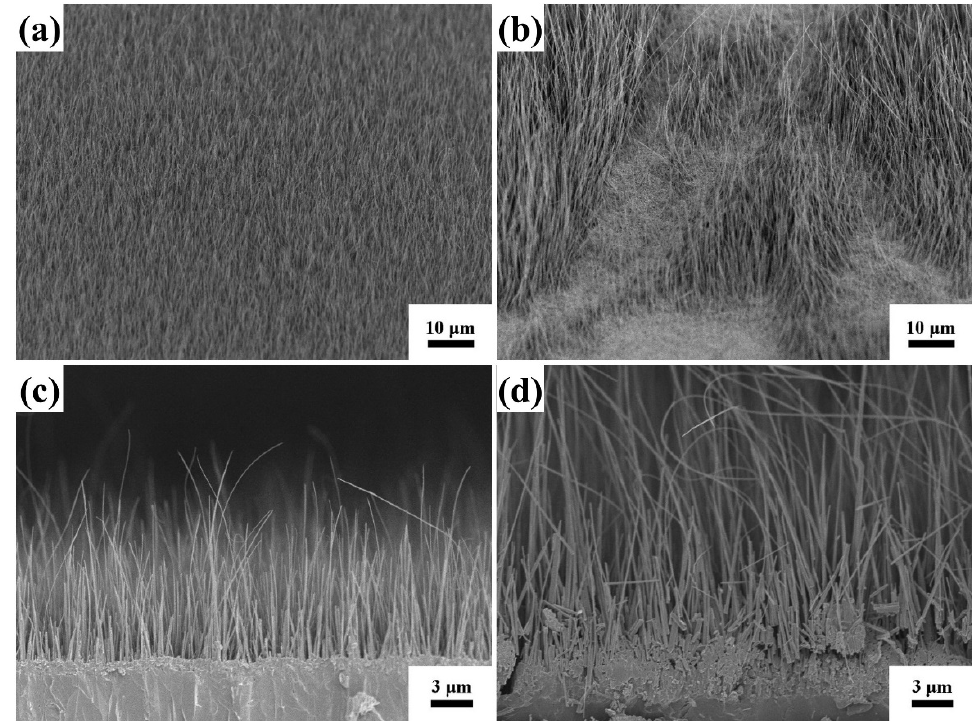
Figure 2. The tilt ‐ view FESEM images of CuO nanowires grown on Cu foil with a ( a ) hotplate and ( b ) furnace at 550 °C for 6 h under ambient conditions. The cross ‐ sectional FESEM images of CuO nanowires grown on Cu foil with a ( c ) hotplate and ( d ) furnace at 550 °C for 6 h under ambient conditions.